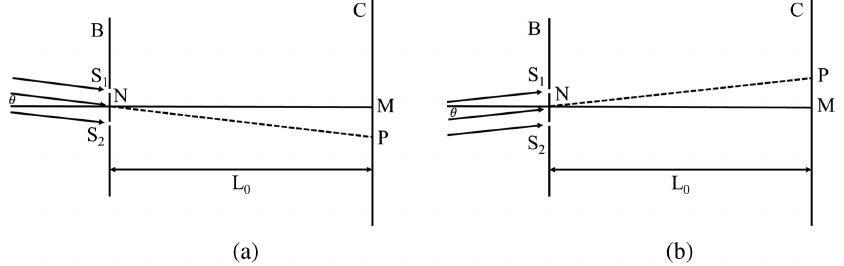
FIG. 7. (a) Q9 and Q11 problem setup. (b) Q10 and Q12 problem